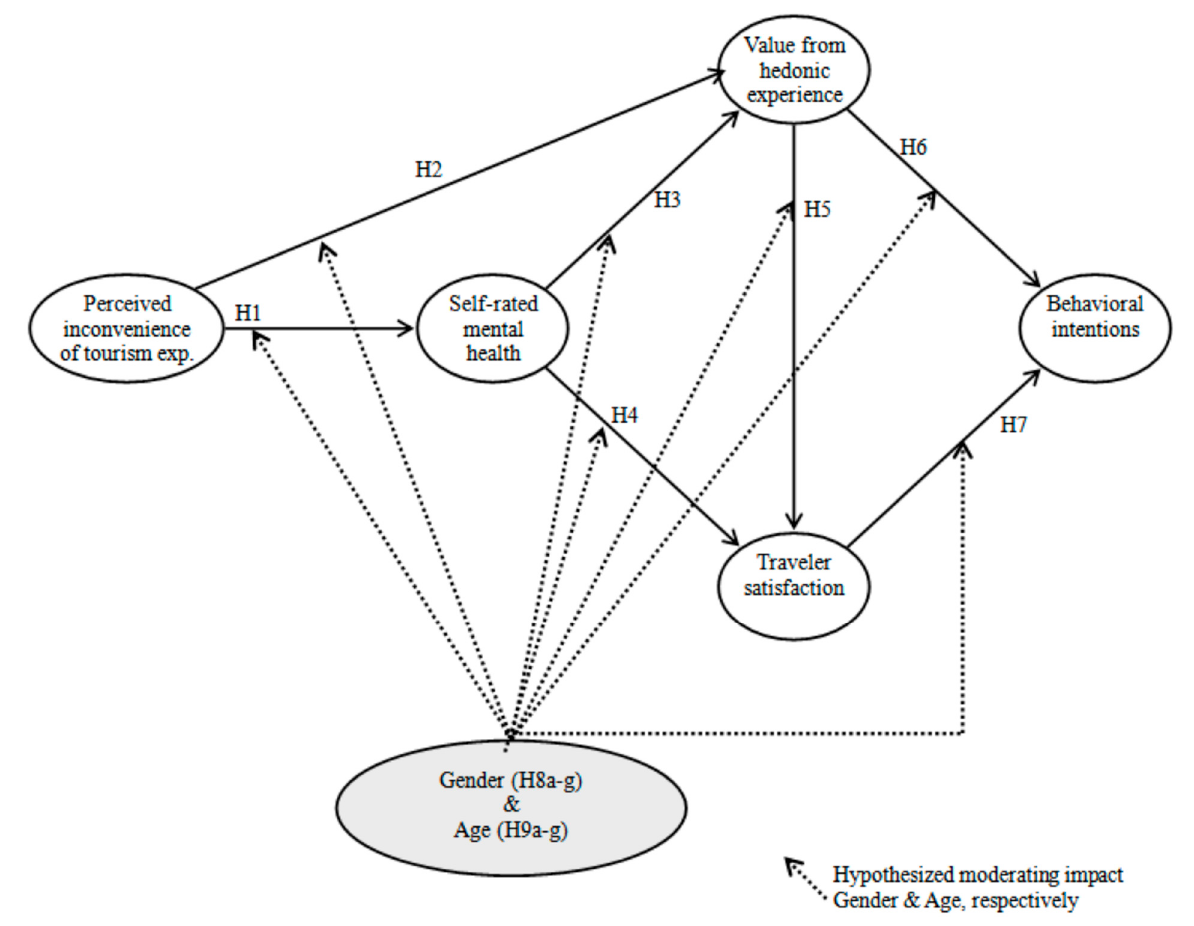
Figure 1. The proposed theoretical framework.